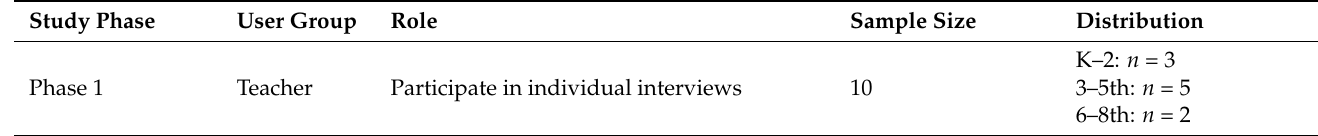
Table 2. Sample size and distribution by